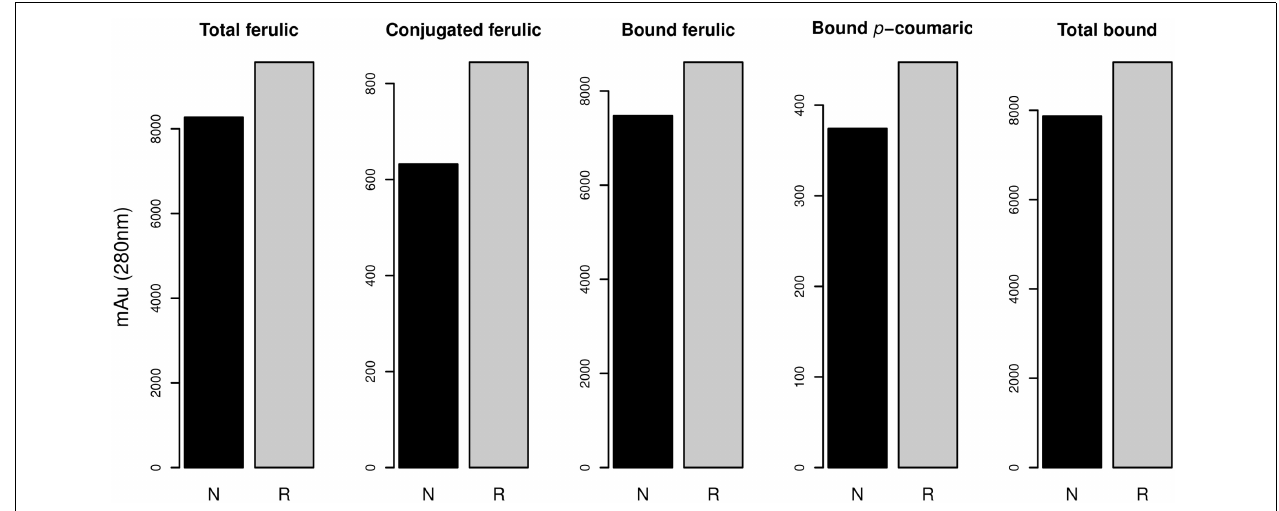
FIGURE 3 | Content of phenolic compounds with a significant effect of the translocation 1RS/RL ( p -value < 0.05; Table 4). N, no translocation; R, translocation 1RS/RL.